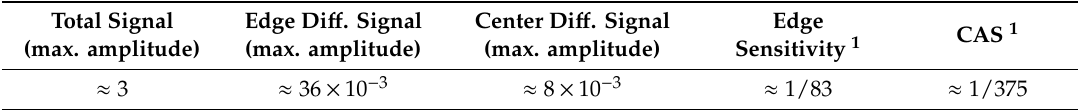
Table 5. Main results from the calculated signals, shown in Figure